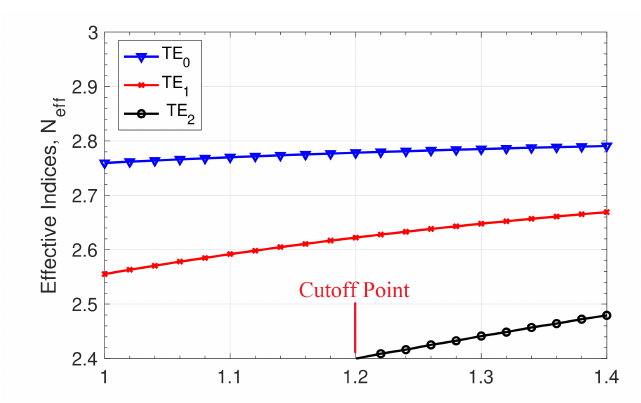
Figure 2. The simulated diagram of effective indices of two TE modes as functions of the the input stem waveguide width.